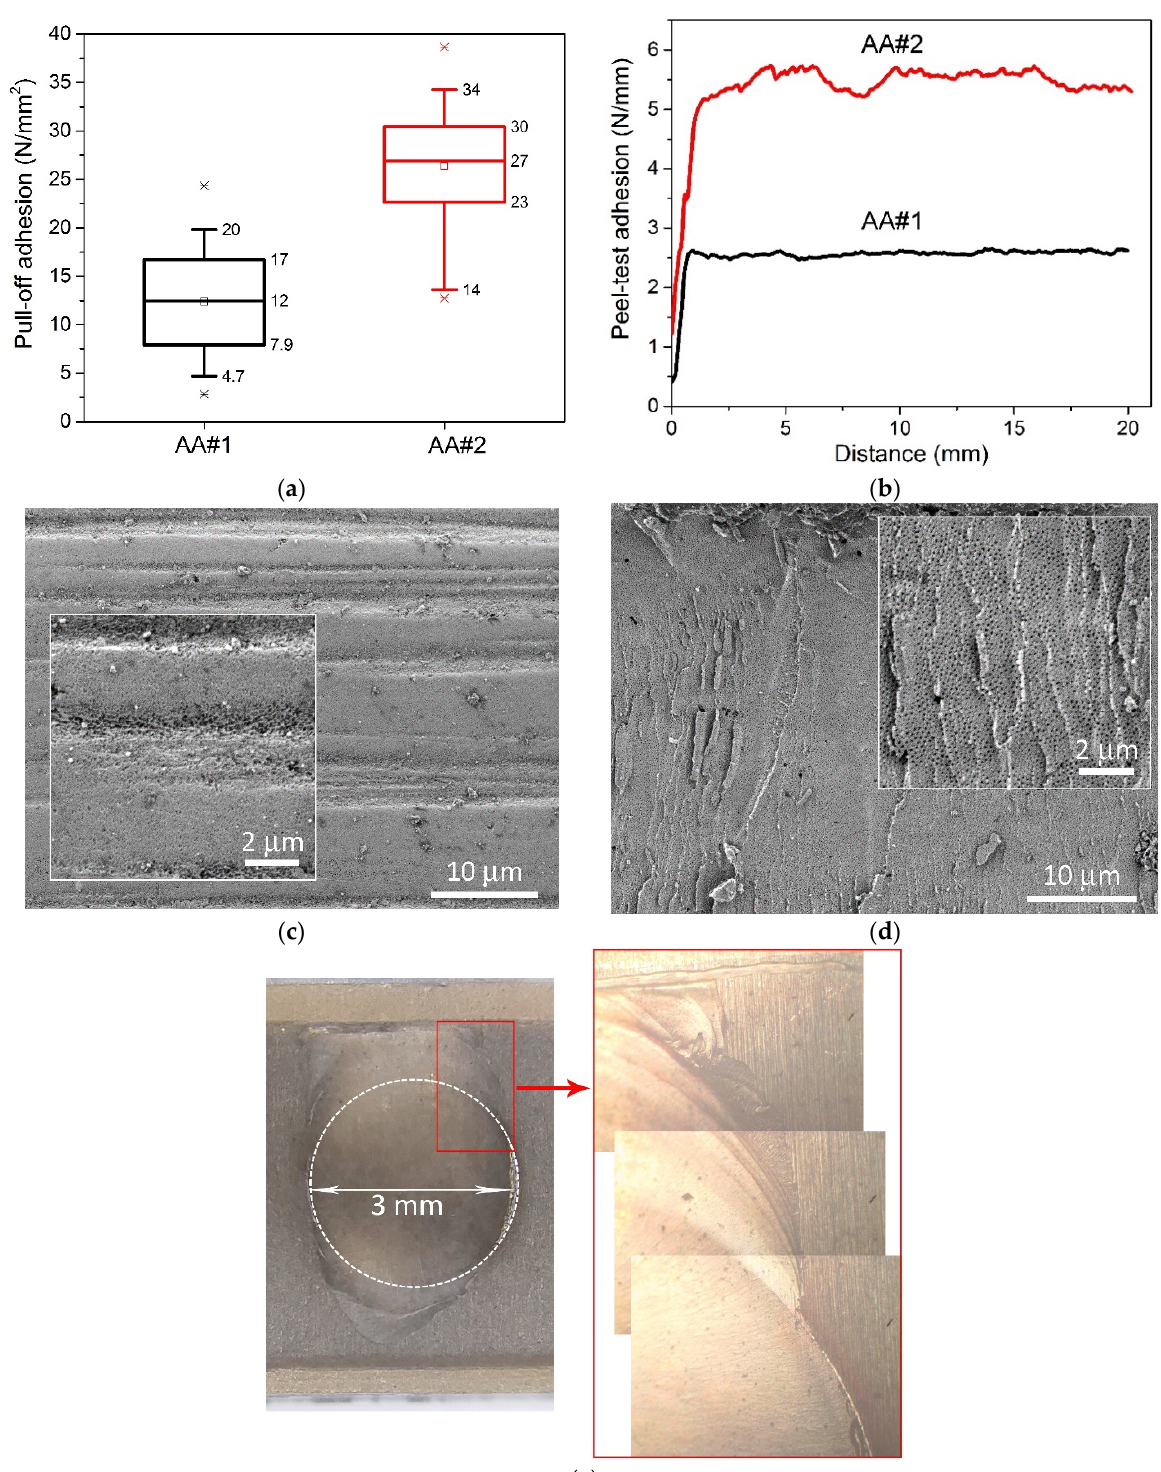
Figure 2. ( а ) Results of pull-off adhesion of 300 µm copper for AA#1 and AA#2 aluminum alloys. ( b ) Peel test adhesion results of 100 µm copper for AA#1 and AA#2 aluminum alloys. ( c ) SEM images of AAO surface planarized in the grinding machine. ( d ) SEM images of AAO surface after adhesion tests. ( e ) Optical images of cohesion failure after pull-off test of AA#2.